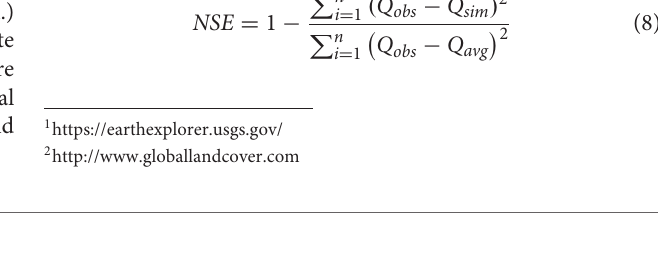
TABLE 1 | List of climatological and hydrological stations in the study basins.